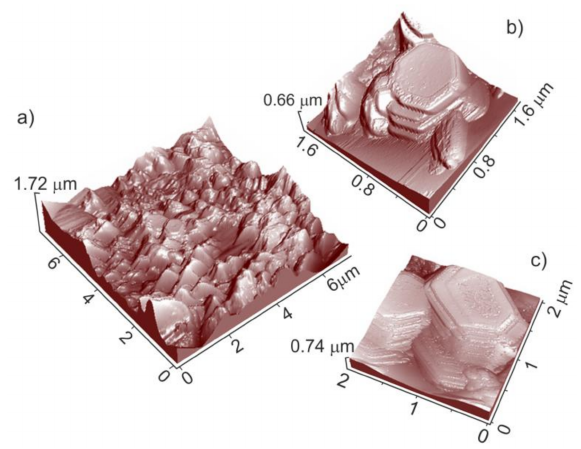
Figure 4. Large-scale non-contact atomic force microscopy (AFM) topographies of ZnO spherical cages grown on Au thin film at 700 ◦ C for 3 h: ( a ) 7 × 7 µ m, ( b ) 1.6 × 1.6 µ m, and ( c ) 2 × 2 µ m